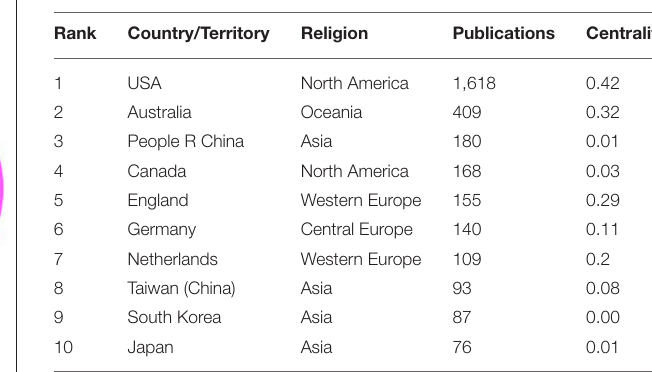
TABLE 2 | The top 10 country/territory in the field of health literacy